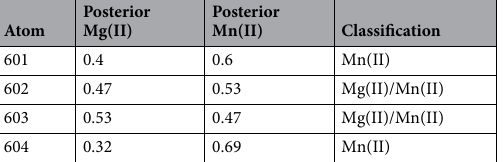
Table 2. Results of machine-learning algorithm (LDA) application in the classification of enzyme active site features. X-ray crystal structure data of T7 DNA primase (PDB entry 1 nui). Atoms designated as 601–604 were taken from the PDB file and represent the locations of the four divalent metal cofactors at the enzyme’s active site. Posterior probabilities were calculated according to the projection on the LDA vector of the feature vector of each